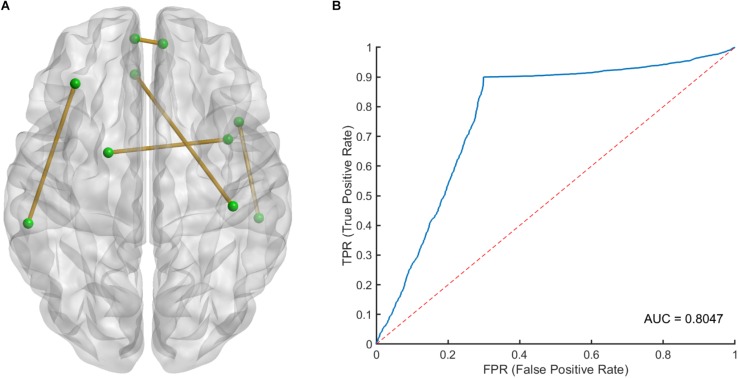
(A) The spatial distribution of five selected LASSO features and (B) the receiver operating characteristic (ROC) curve of the classification model. LASSO, least absolute shrinkage and selection operator.